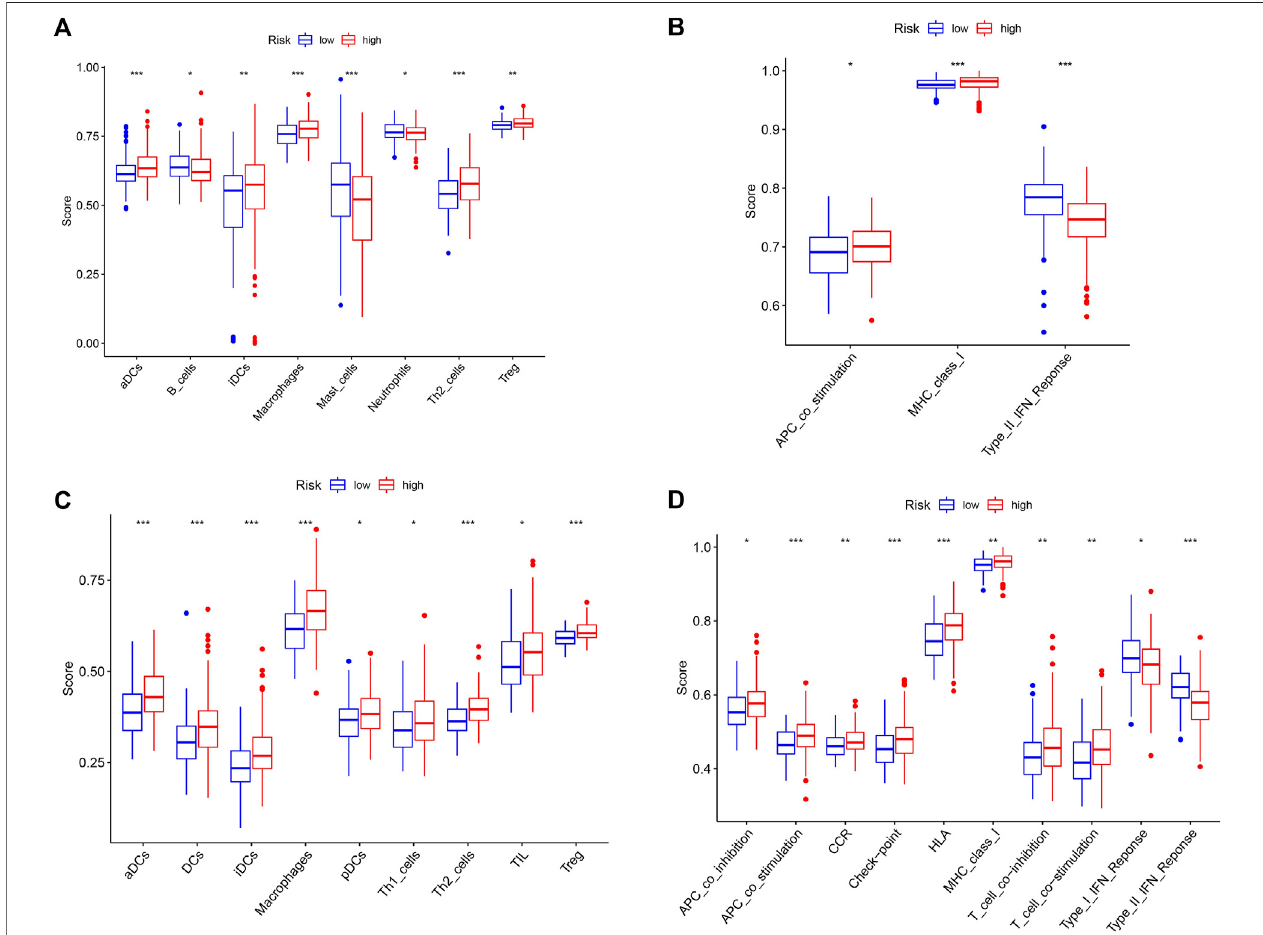
FIGURE7| Correlationanalysisofriskgroupsandimmunestatus. (A) ImmunecellscoresfordifferentriskgroupsintheTCGAcohort. (B) Immune-relatedpathway scores for different risk groups in the TCGA cohort. (C) Immune cell scores for different risk groups in the ICGC cohort. (D) Immune-related pathway scores for different risk groups in the ICGC cohort. *, p < 0.05; **, p < 0.01; ***, p < 0.001.